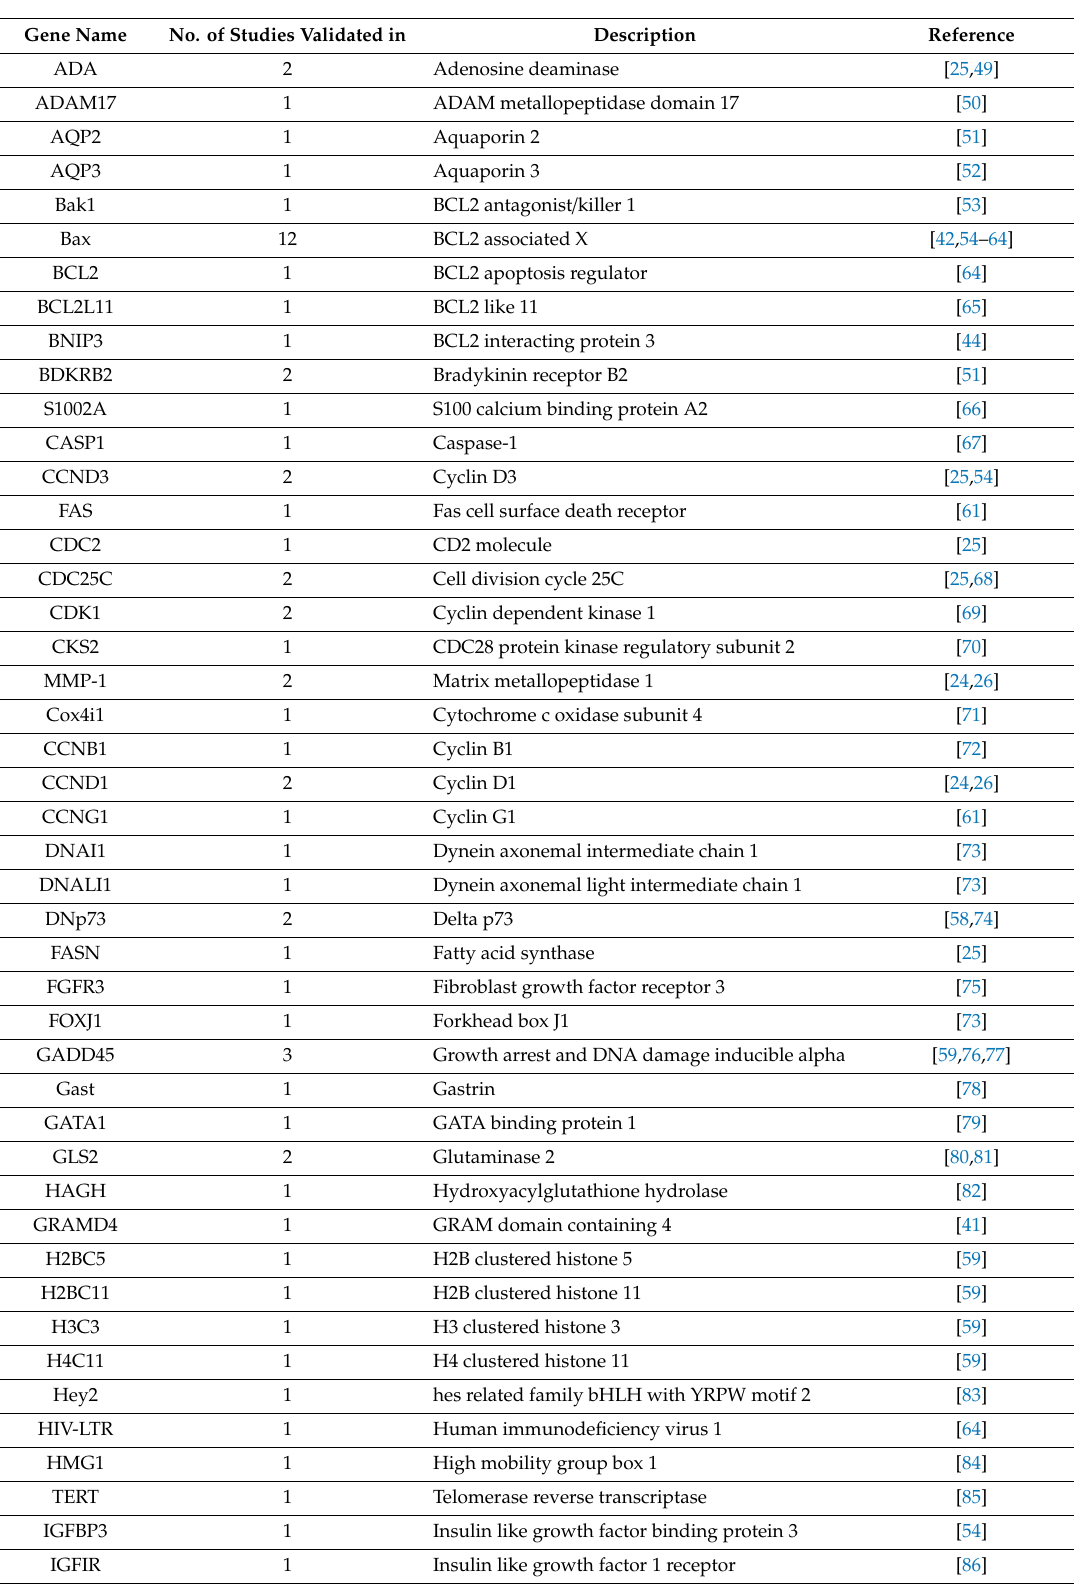
Table 1. List of genes validated as TAp73 direct targets from 71 focused